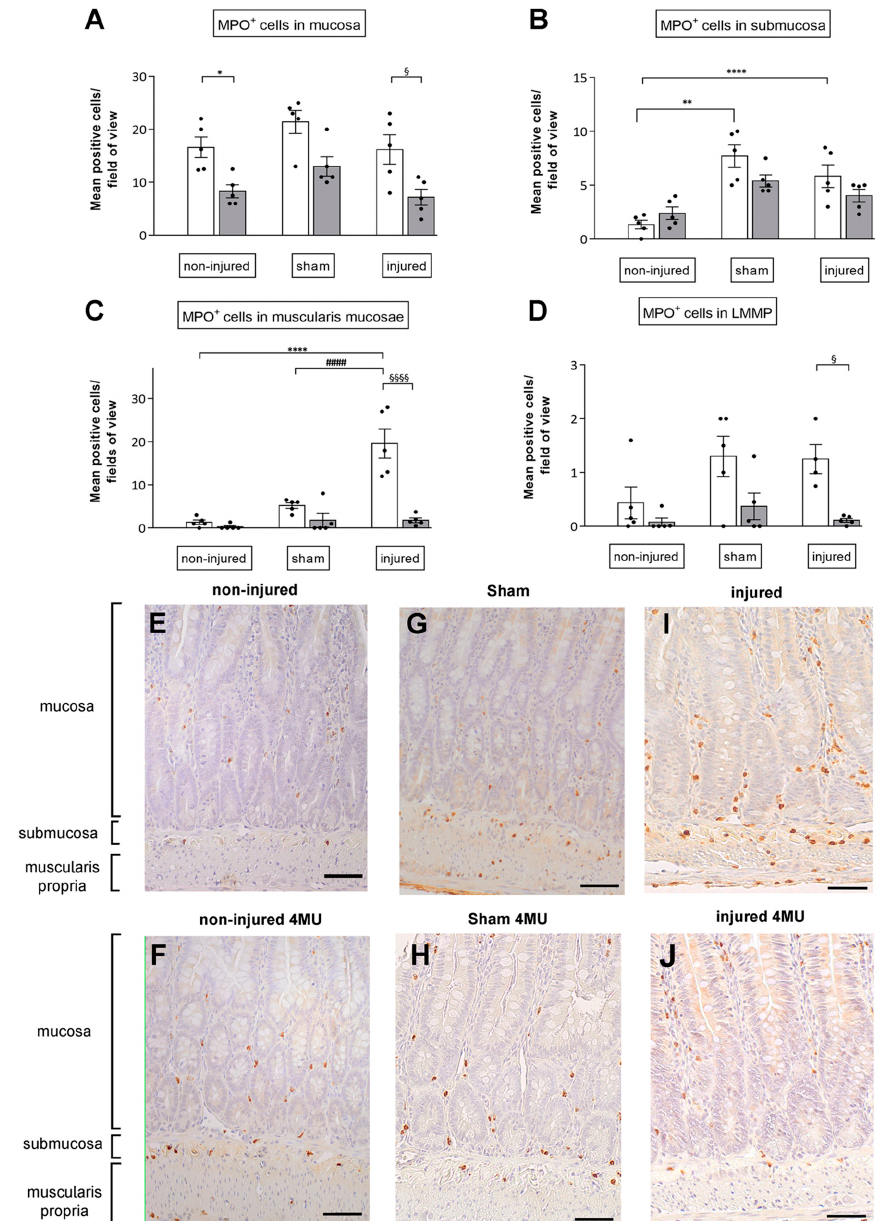
Figure 2. Immunostaining reveals increased number of MPO + cells in the muscularis propria of injured animals. Neutrophil infiltrate expressed as number of MPO + cells in the rat small intestine in the mucosa ( A ), submucosa ( B ), muscularis propria ( C ) and in myenteric ganglia ( D ) in the different experimental groups as indicated on top of graph in the absence (white columns) and presence of 4-MU 25 mg/kg (grey columns). Values are expressed as mean ± SEM of neutrophil count. **** ,§§§§,#### p < 0.0001, ** p < 0.01, * p < 0.05 and § p < 0.05 by one-way ANOVA followed by Tukey’s test. N = 5 rats/group. ( E – J ): MPO + cells are evident for their brown staining (panels are representative of cross-sections obtained from all experimental groups as indicated, scale bar = 20 µ